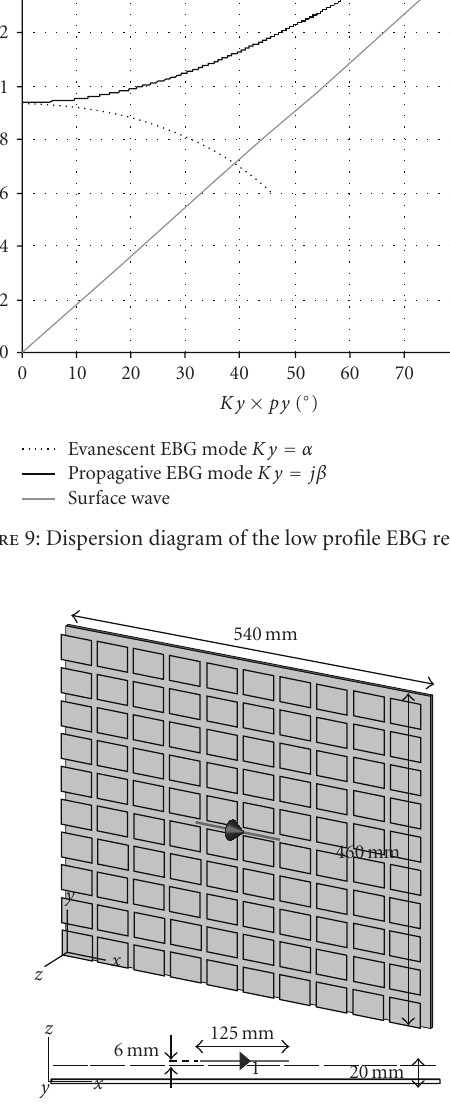
Figure 10: Low profile EBG resonator